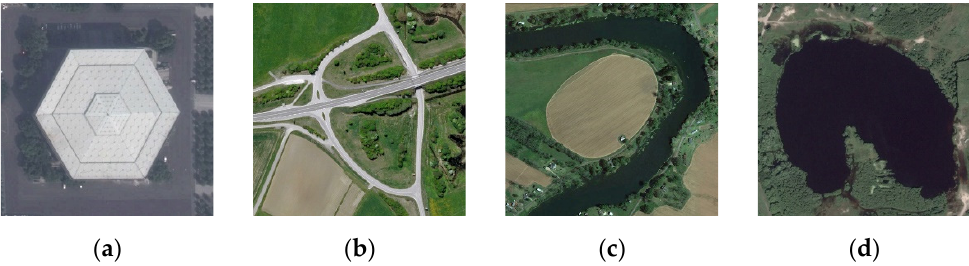
Figure 2. Remote sensing images. ( a ) S1 image, ( b ) S2 image, ( c ) S3 image, and ( d ) S4